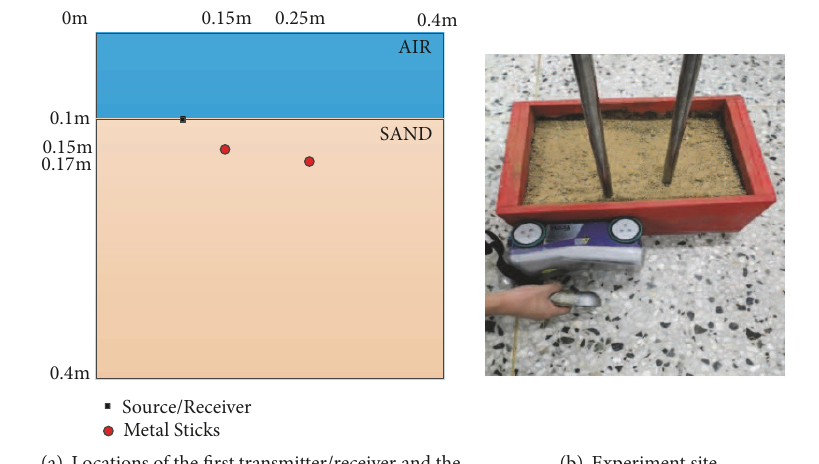
Figure 8: Imaging with experimental data.